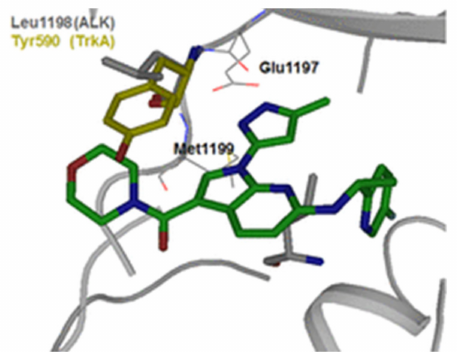
Figure 10. Cocrystal structure of compound B in ATP binding site of human ALK protein (gray). The relative position of Tyr590 based on crystal structure is shown in yellow [12].